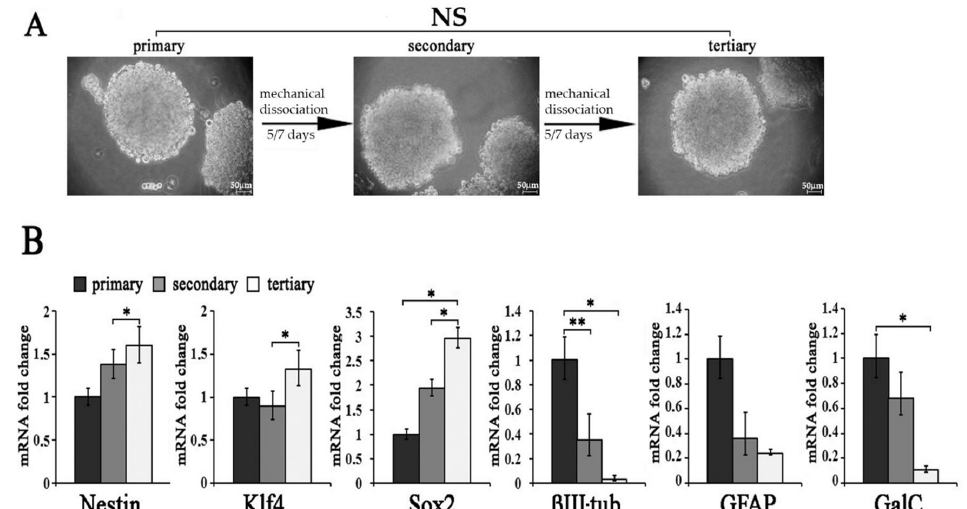
Figure 2. Molecular characterization of und-Ns subcultures ( A ) Neurospheres (Ns) originated from undifferentiated A1